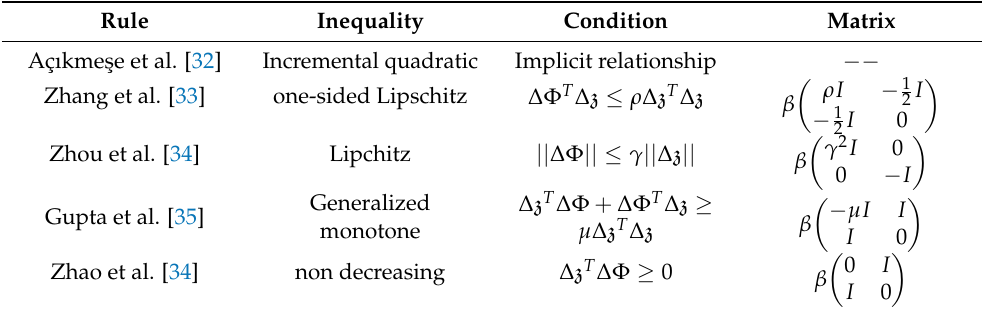
Table 1. Results of inequalities leading to special matrixes satisfying IQC.